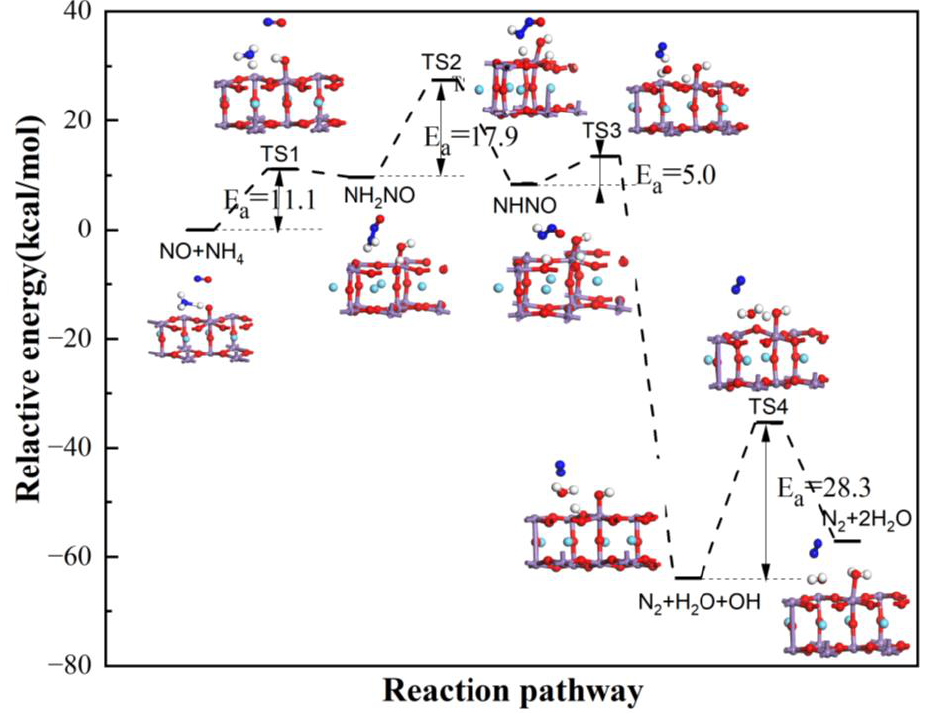
Figure 15. The NH 4+ reaction process in the Figure 13b configuration over the catalyst.